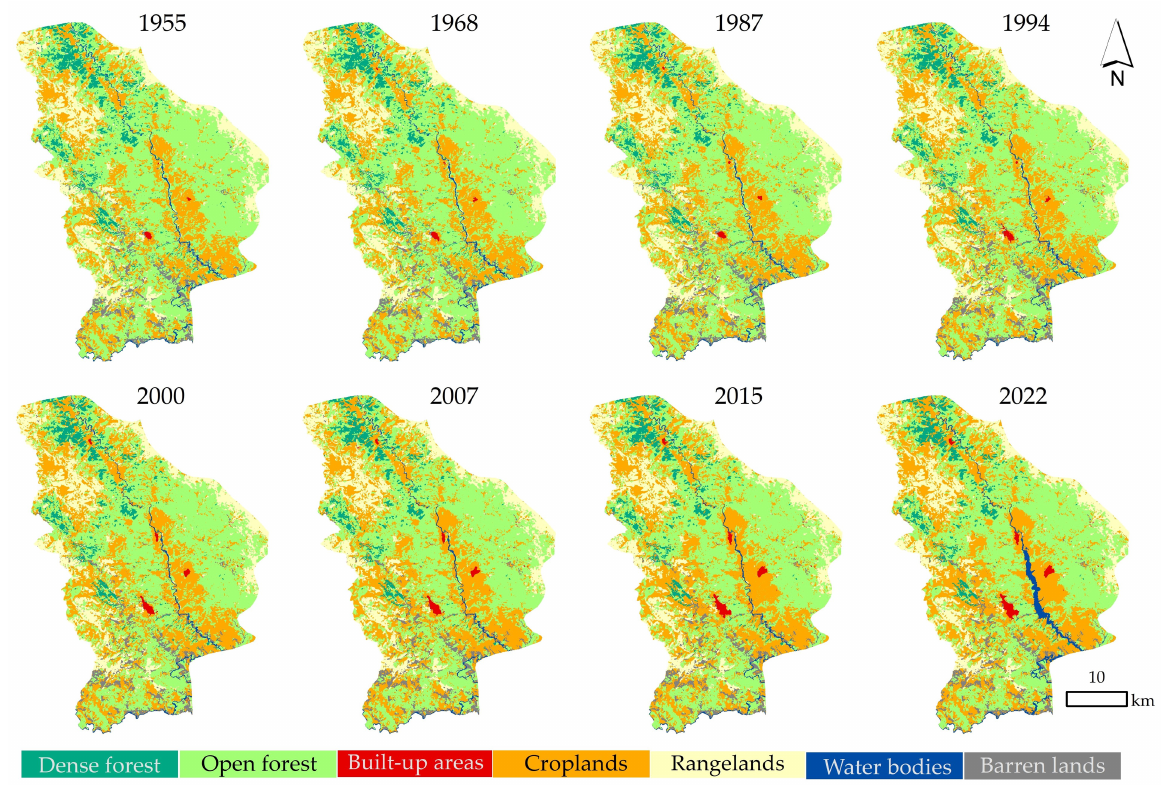
Figure 5. Sardasht County’s land use maps within the studied time